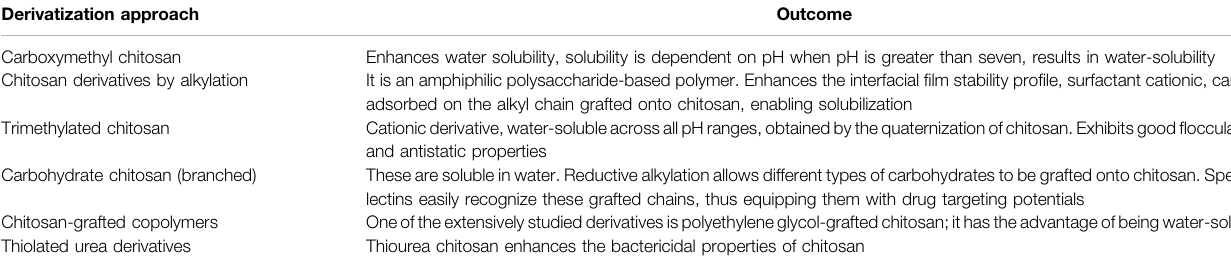
TABLE 2 | Functionalized types of chitosan and their respective